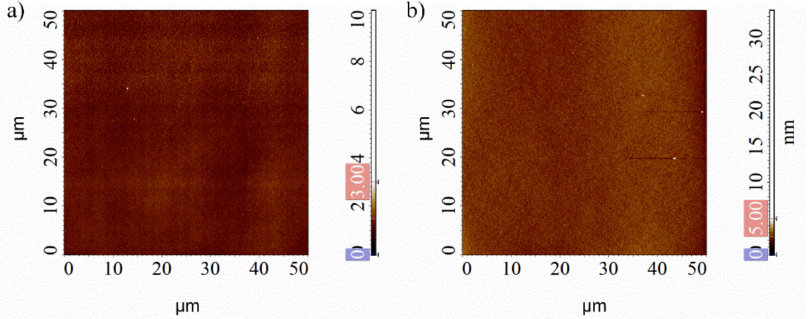
Figure 2. High resolution SensHeight AFM images of silicon nitride ( a ) and PMMA ( b )